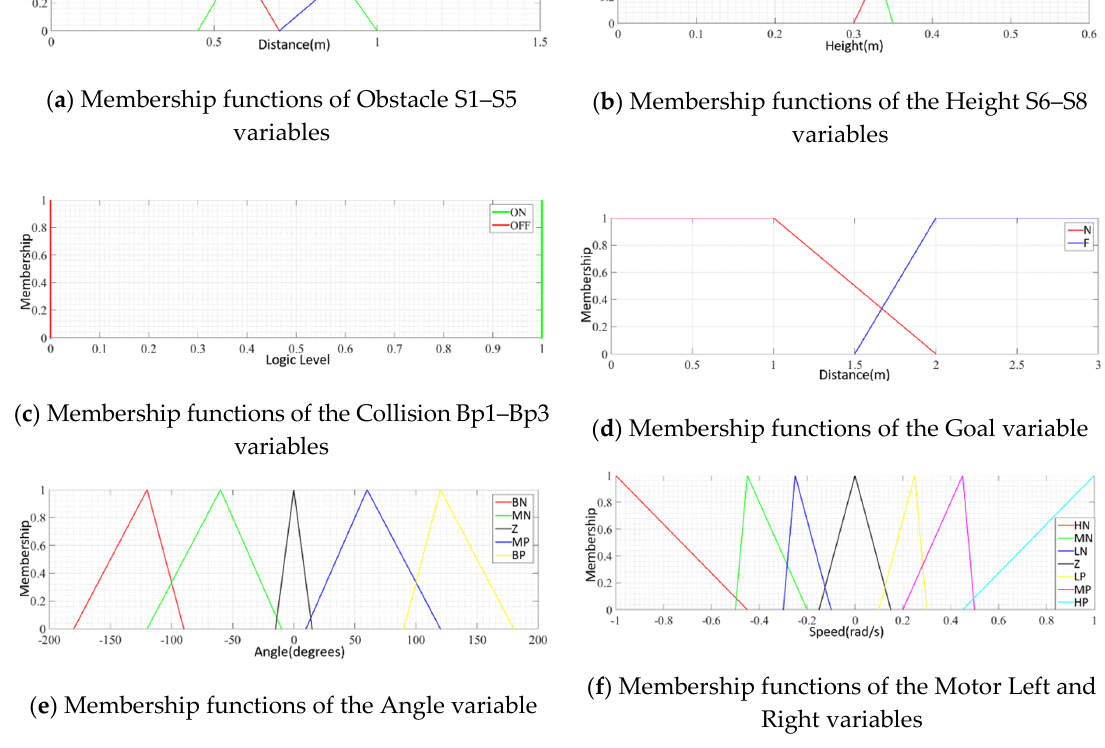
Figure 14. Membership functions of FIS input and output variables.